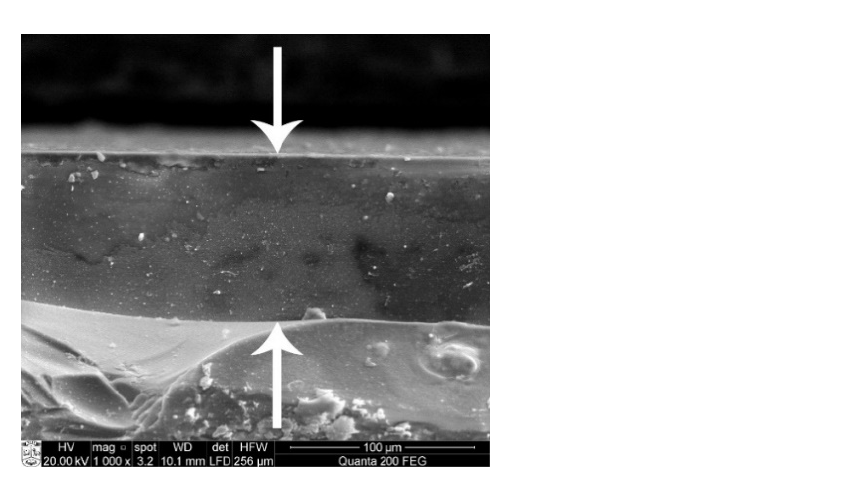
Figure 5. SEM cross-section image of In-incorporated Cu x Se annealed film on glass. Treatment with copper(II/I) ion solution was 10 min at 60 °C.